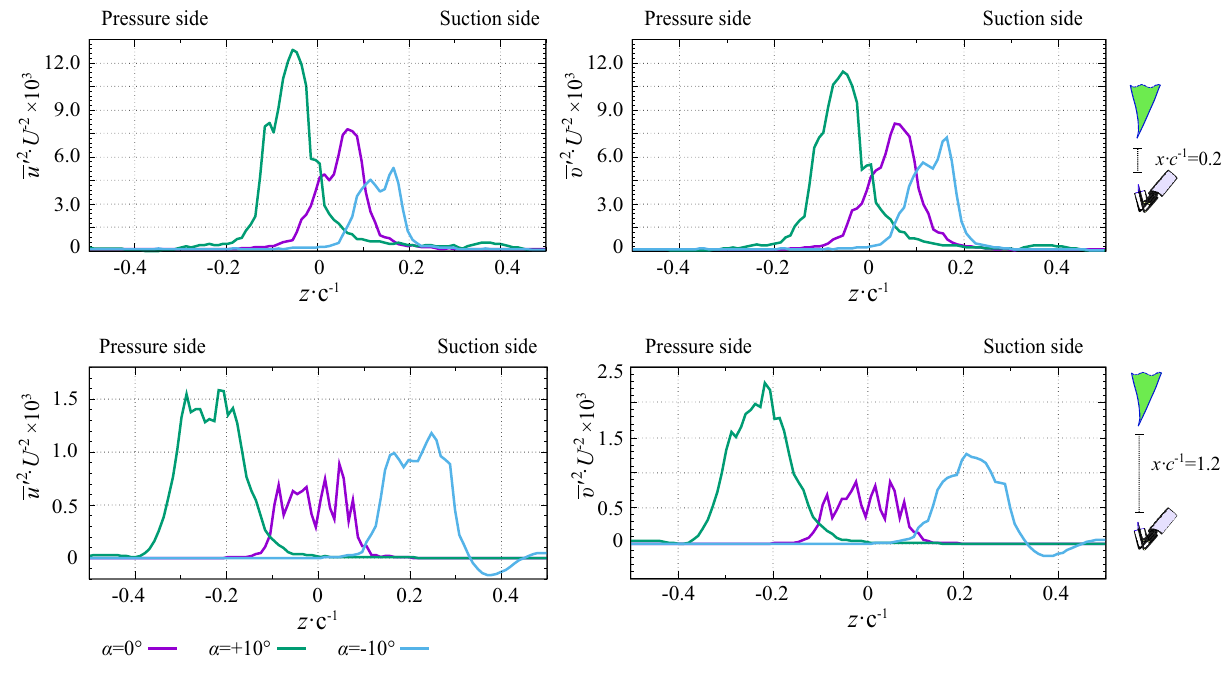
Fig. 5 Normalized distribution of Reynolds stress components u � 2 ⋅ U − 2 , 𝜐 � 2 ⋅ U − 2 , u � 𝜐 � ⋅ U − 2 at Re ≈ 1.7 × 10 5 and different x ⋅ c 1 . Green, blue, and light blue curve indicate the position of the angle of attack 𝛼 = + 10 ◦ ,0 ◦ and − 10 ◦ ,